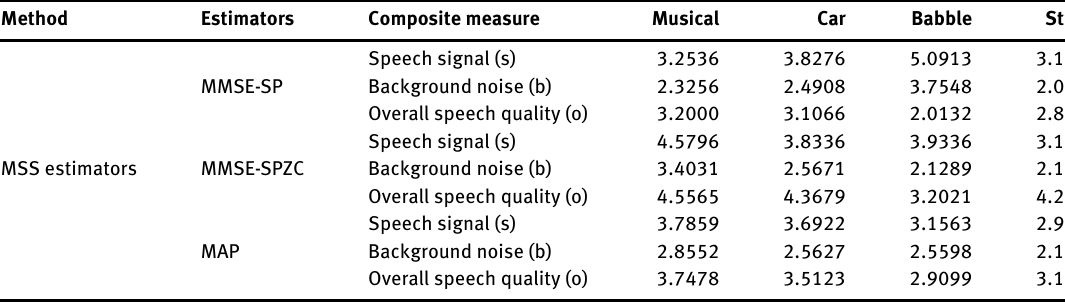
Table 9: Performance Evaluation of MSS Estimators Using Composite Measure for Kannada